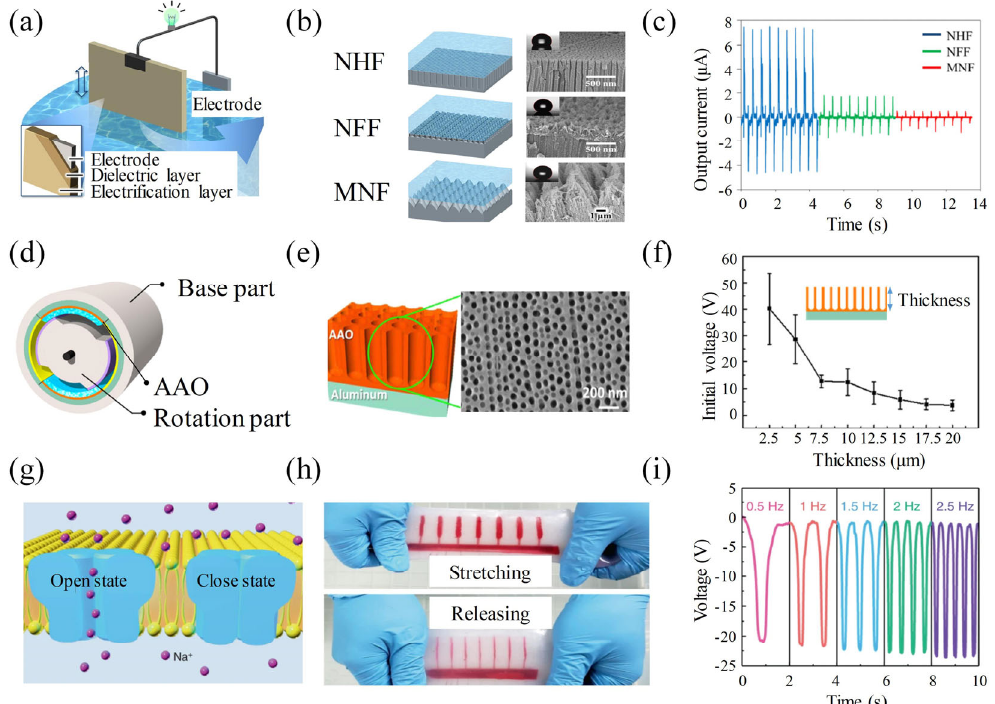
Figure 3 Bio-inspired waving or flowing water-driven electricity generator. (a) Schematic illustrations of a typical waving or flowing water-driven electricity generator. (b) Comparisons of structural illustrations and SEM images of different surface. (c) Comparisons of short-circuit current for different surface structures. (a)–(c) Reproduced with permission from Ref. [91], © Elsevier B.V. 2018. (d) Schematic illustration of the lotus leaf-inspired closed-structure electricity generator. (e) Structure of the AAO. (f) Dependency of electrical output on the thickness of the AAO structure. (d)–(f) Reproduced with permission from Ref. [94], © American Chemical Society 2016. (g) Structural illustration of electric eel cell’s ion channel. (h) Electric eel cell-inspired stretchable electricity generator. (i) Electrical output of the electric eel cell-inspired stretchable electricity generator. (g)–(i) Reproduced with permission from Ref. [95], © Zou, Y. et al.